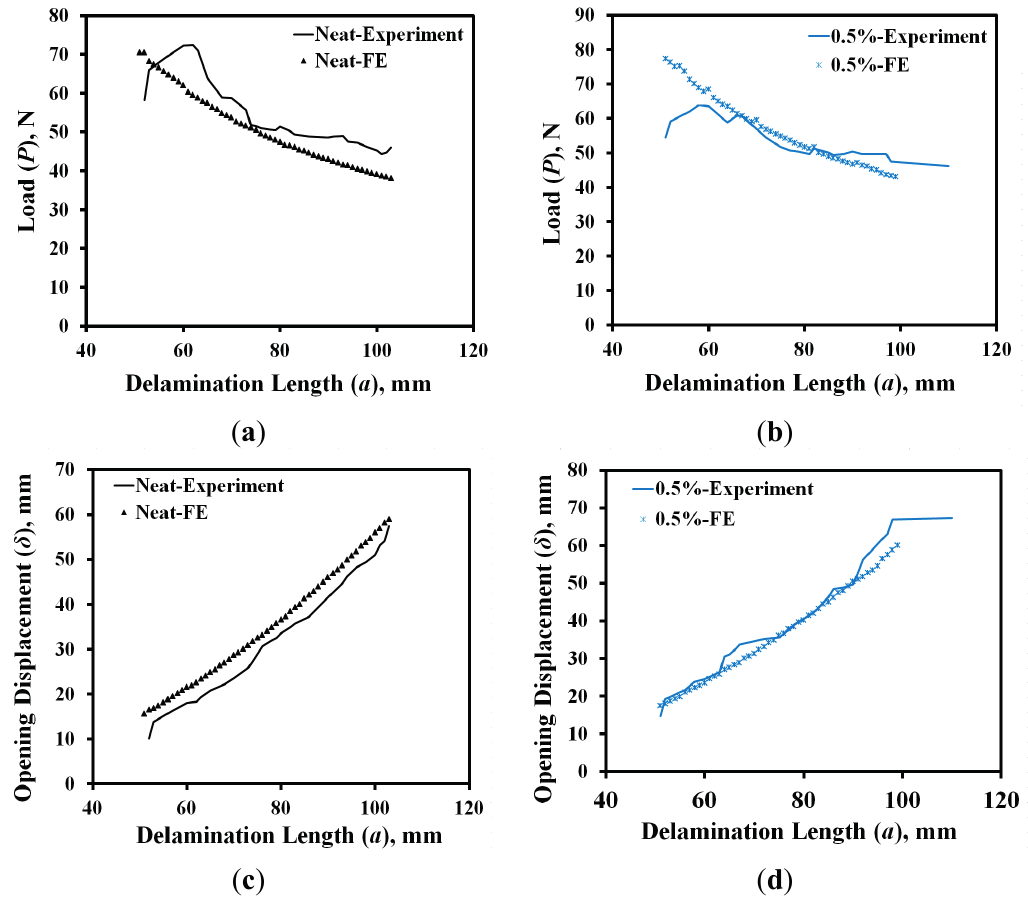
Figure 19. Comparison between the experimental and numerical behavior of ( a ) delamination growth vs. load for unidirectional CFRP composites with 0.0 wt% MWCNTs and ( b ) 0.5 wt% MWCNTs, ( c ) delamination growth vs. opening displacement for unidirectional CFRP composites with 0.0 wt% MWCNTs and ( d ) 0.5 wt% MWCNTs.